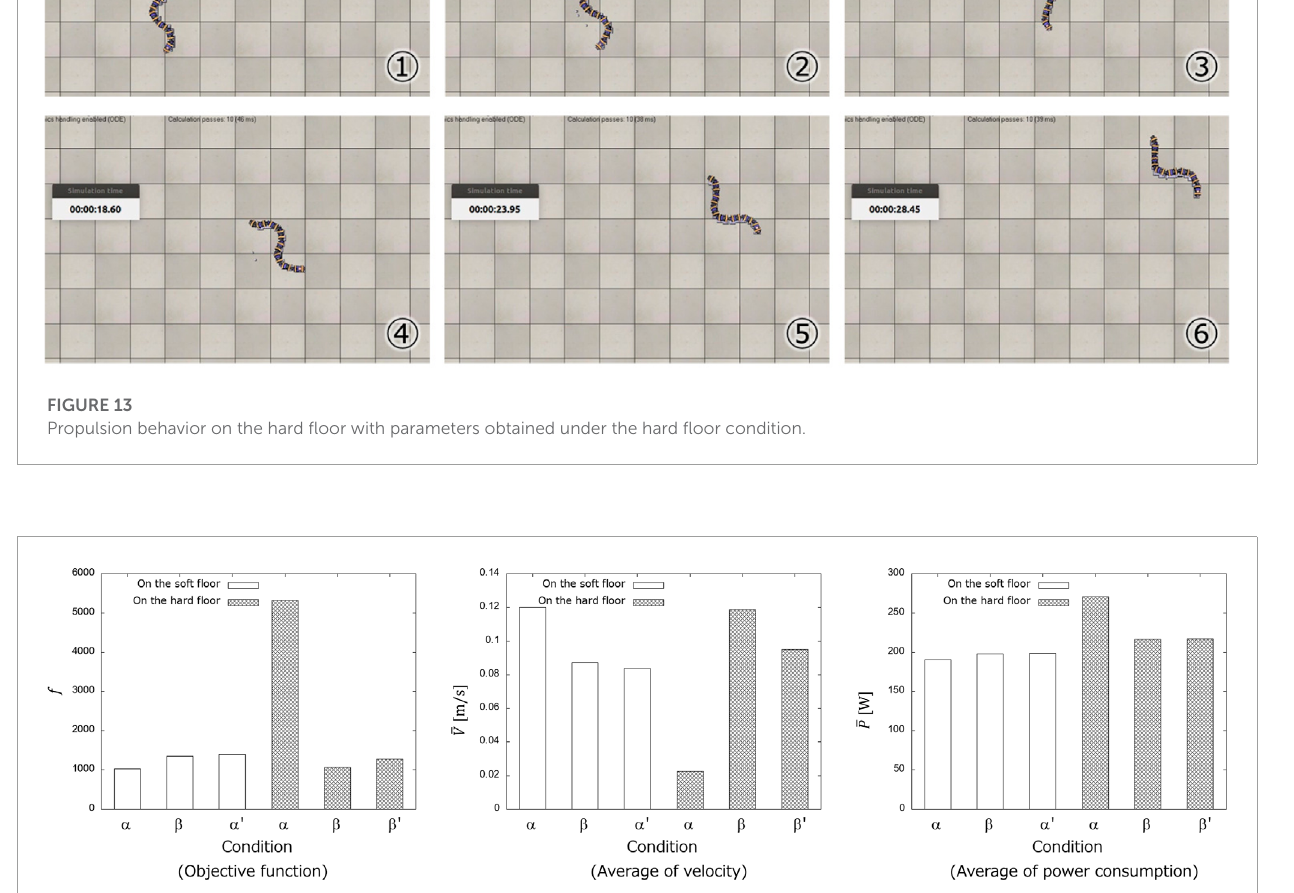
FIGURE 14 Results of propulsion experiment. Condition α , β , α ′ and β ′ are in parameters obtained under the soft floor condition, obtained under the hard floor condition, obtained under the soft floor condition when feedback was cut off, obtained under the hard floor condition when feedback was cut off,